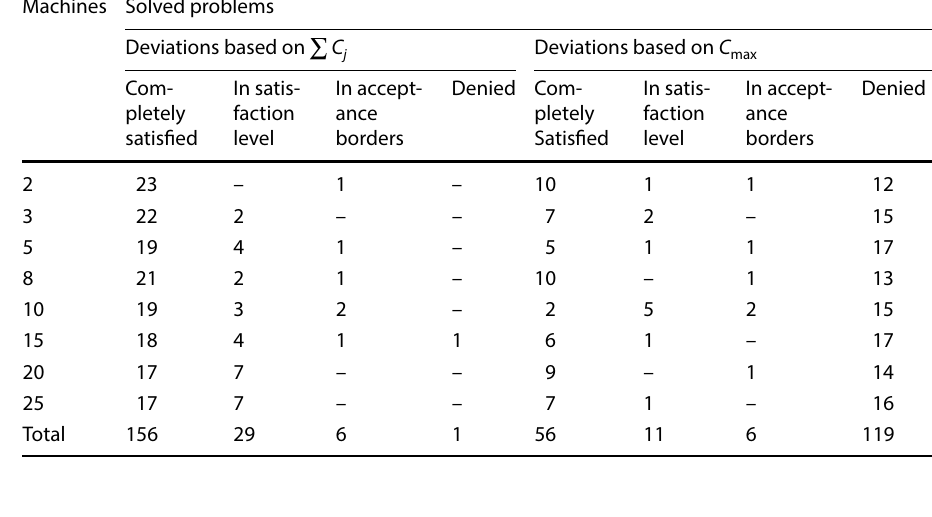
Table 7 Satisfaction status based on ∑ C j and C objectives